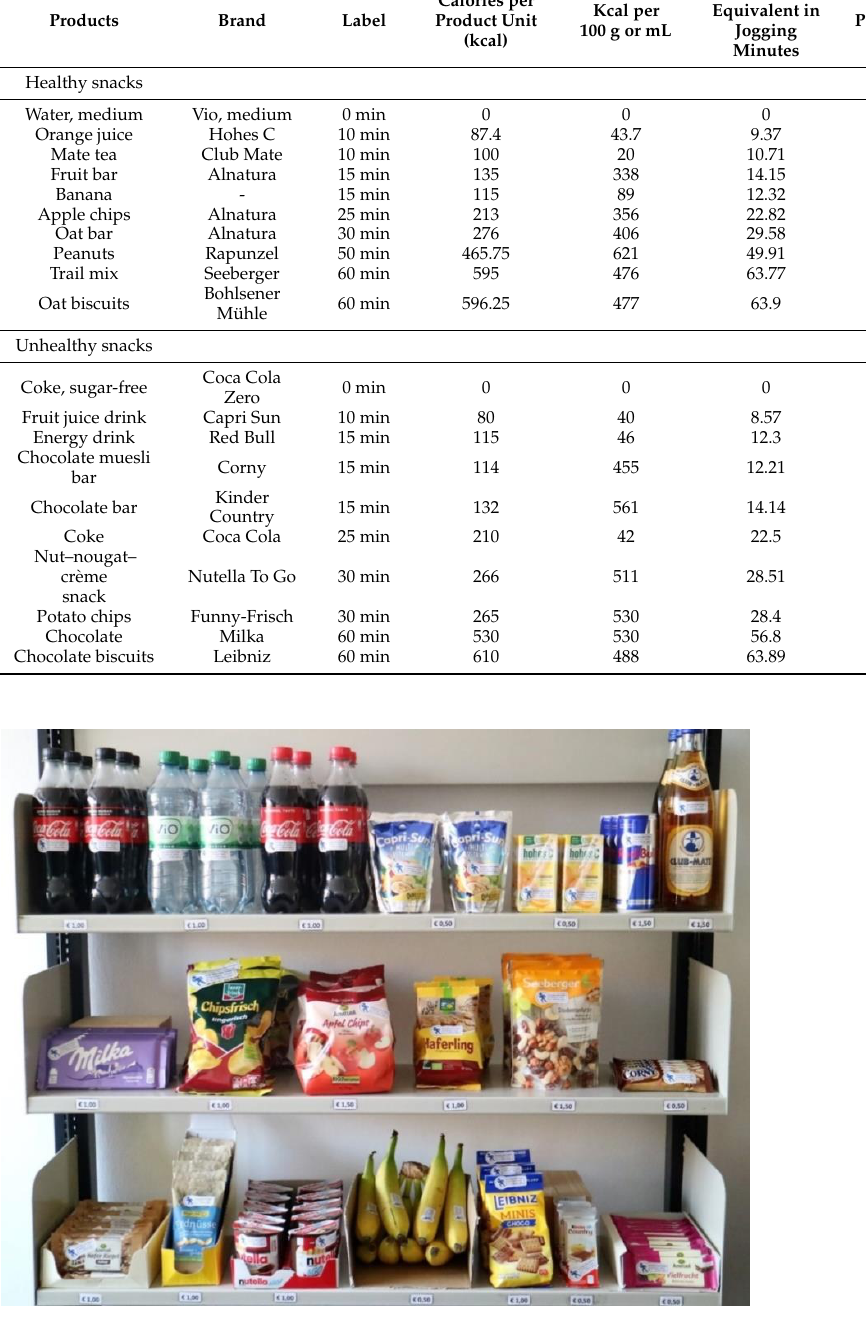
Figure 2. Setup of the snack shelf in the laboratory supermarket during the eye-tracking experi-